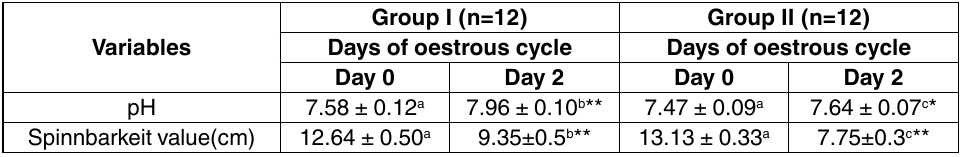
table 2. Comparison of pH and Spinnbarkeit value of cervical mucus discharge during oestrus and metoestrus period in cows with and without metoestrual bleeding